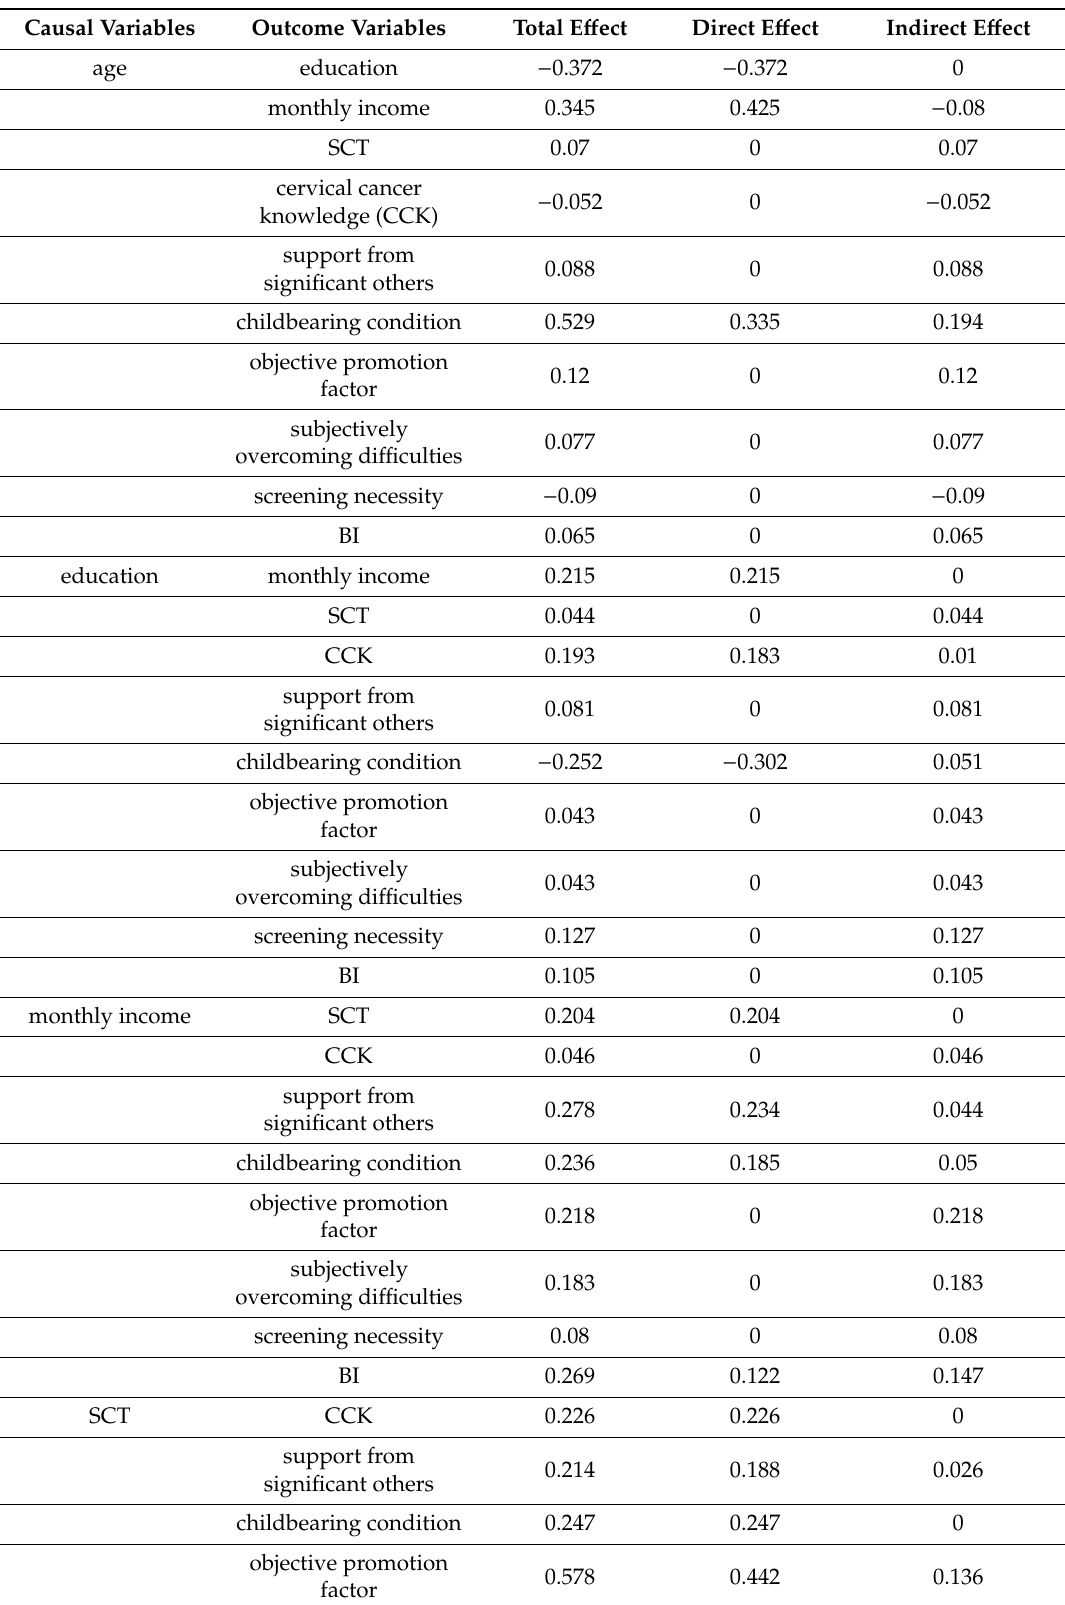
Table 5. Path coe ffi cients decomposition of the BI of cervical cancer screening ( n = 496). Causal